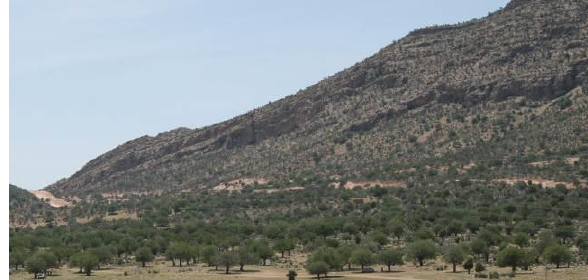
Figure 3. The study area covered with wild pistachio trees.